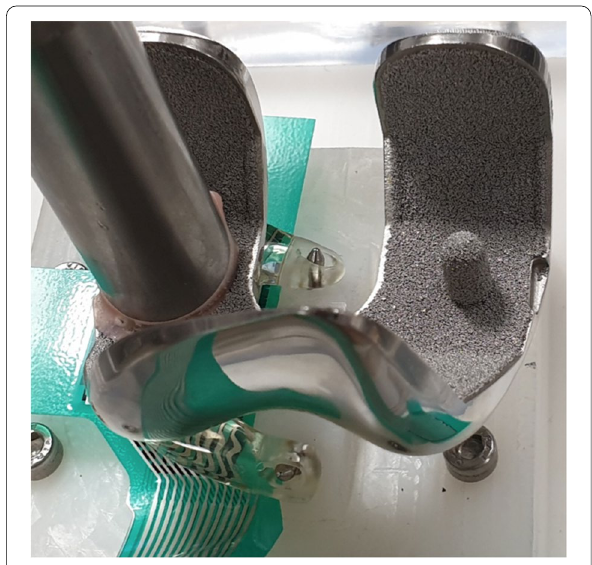
Fig. 7 First-generation meniscus prosthesis and sensor in the artificial knee